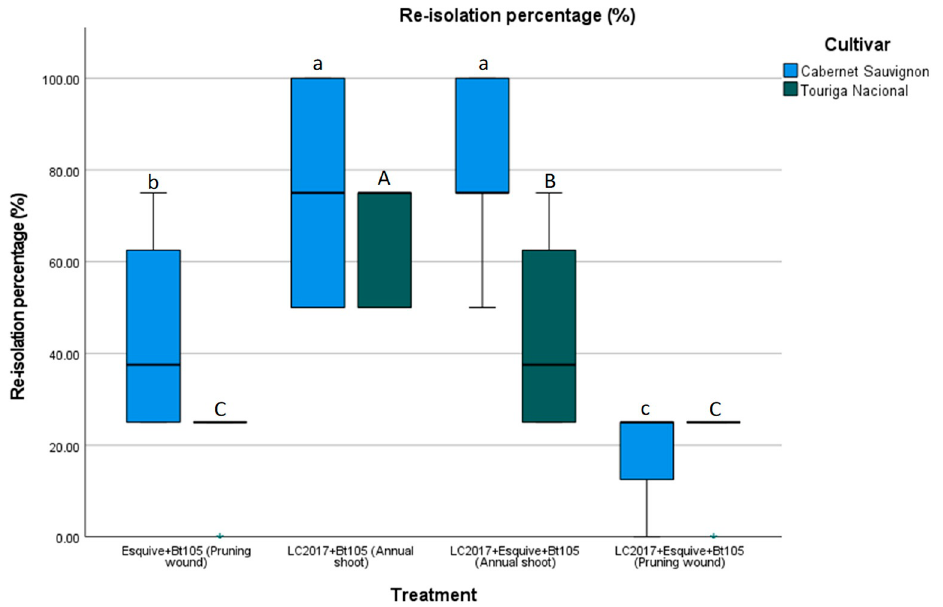
Figure 3. Boxplot representing the re-isolation percentage of L. theobromae (isolate Bt105) were recorded from the cuttings of two cultivars, Cabernet Sauvignon and Touriga Nacional. The re- isolation percentage was calculated as the mean percentage of wood fragments showing pathogen growth for each treatment. The median is represented by the solid line. Different letters in the same column correspond to significant differences ( p < 0.05) based on ranks assessed by Kruskal–Wallis analysis. Upper-case letters refer to Cabernet Sauvignon, and lower-case letters to Touriga Nacional. T. atroviride was only recovered from cuttings treated with Esquive ® . Lower T.